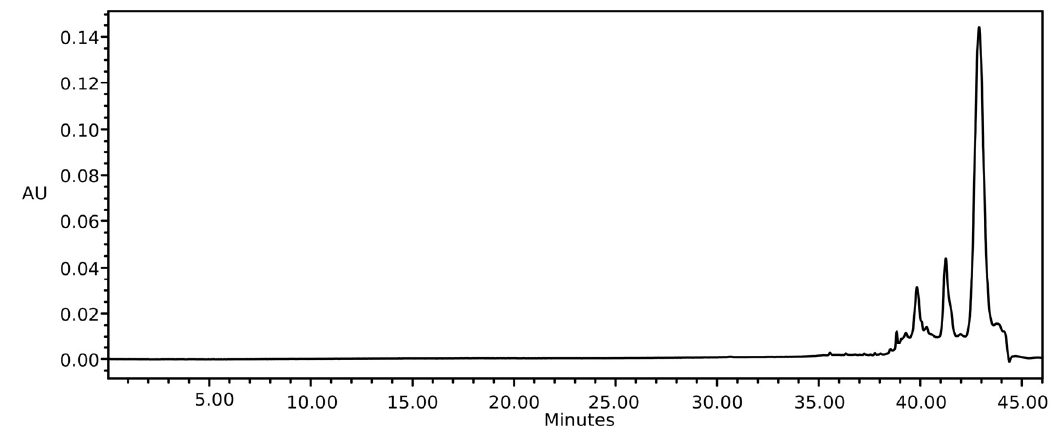
Figure 4. Chromatograms of the commercial passion fruit oil.